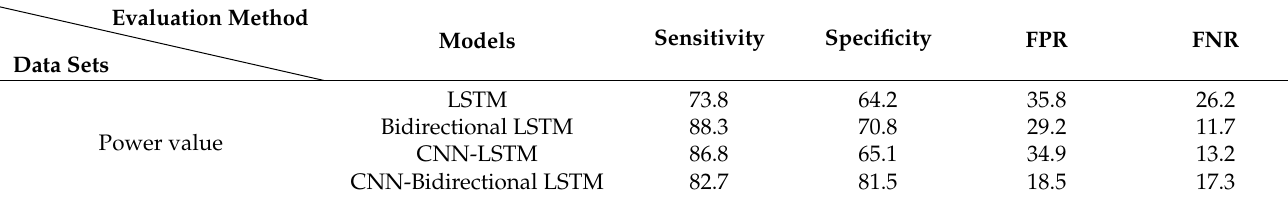
Table 7. DL models’ accuracy, precision, and F1-score based on relative values.